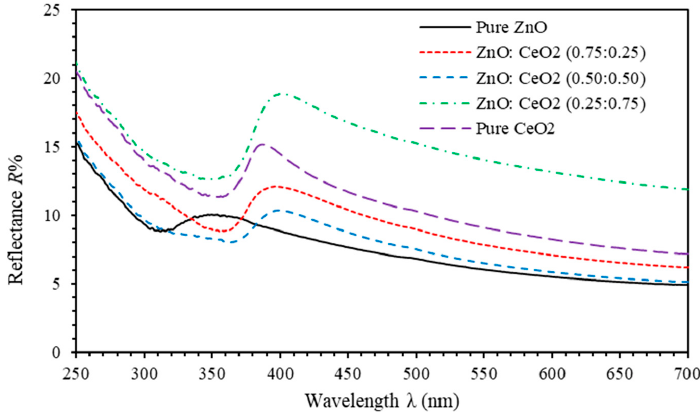
( λ ) spectra of pure ZnO, pure CeO Figure 6. Reflectance 𝑅%(𝜆) spectra of pure ZnO, pure CeO 2 and ZnO:CeO 2 mixed oxides thin films. Figure 6. Reflectance R %